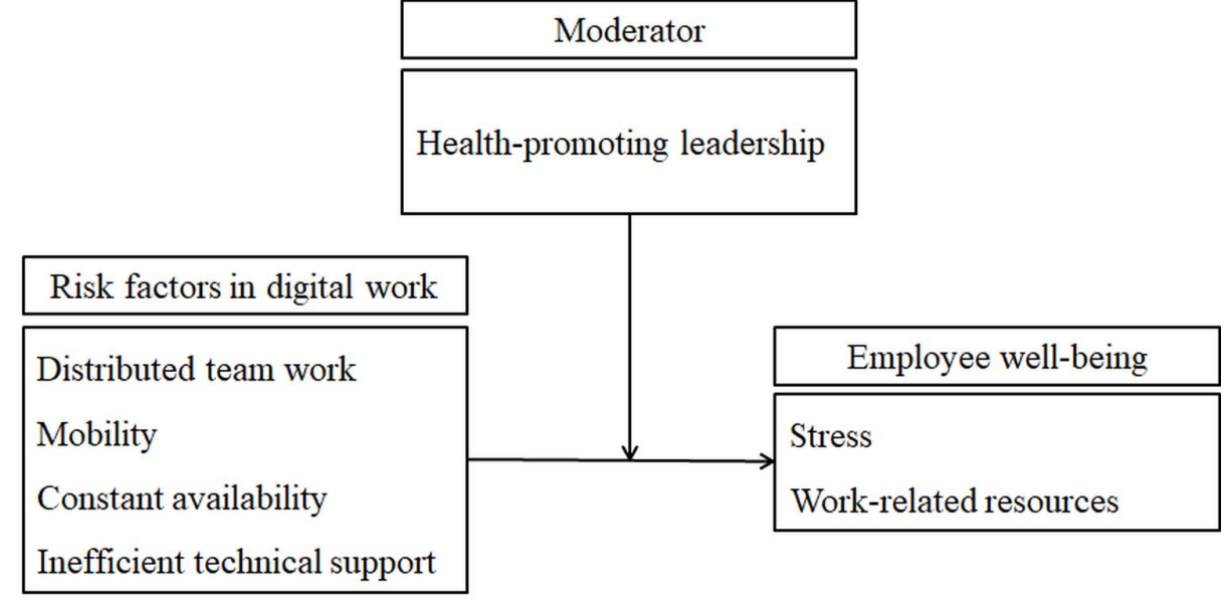
Figure 1. Overall conceptual model of the